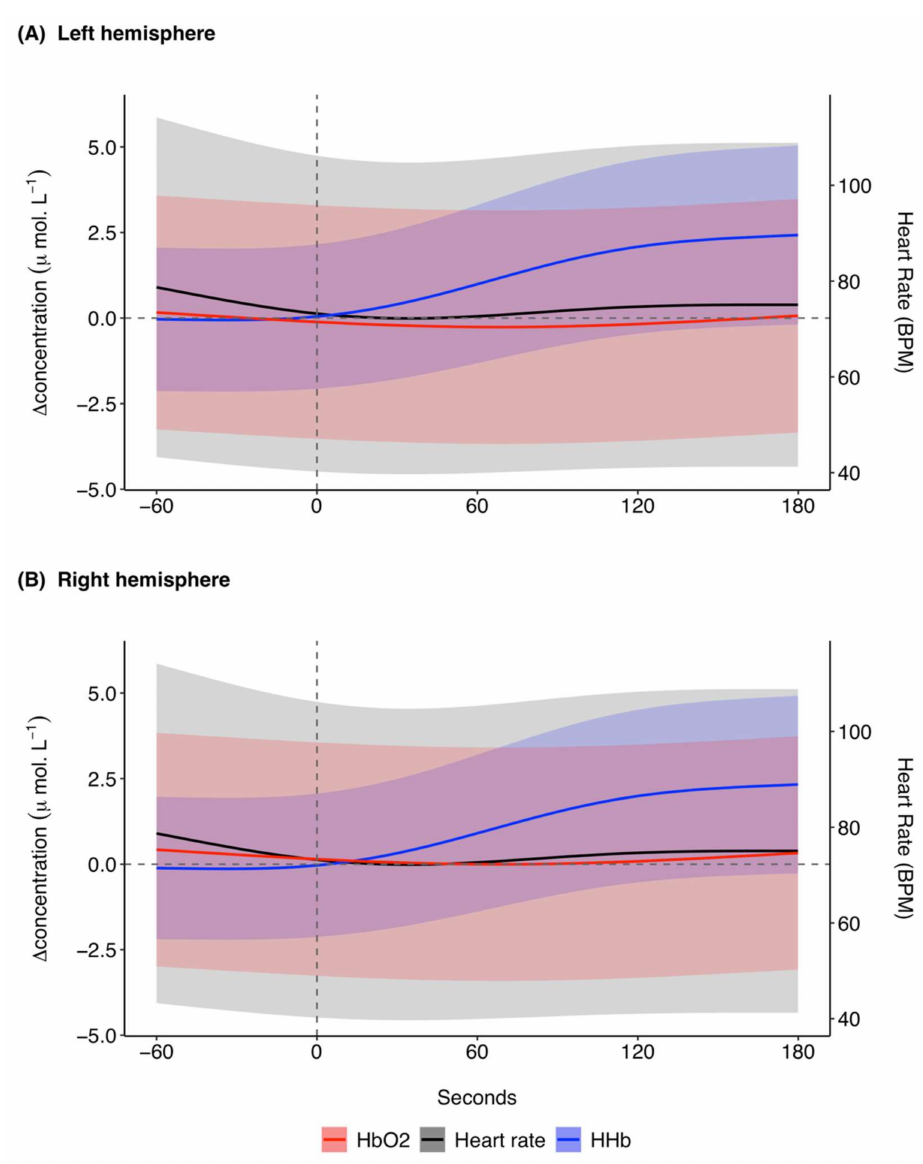
Figure 6. GAMM model prediction outcomes for [ ∆ HHb] ( µ mol L − 1 ), [ ∆ O 2 Hb] ( µ mol L − 1 ), and heart rate (BPM) in the ( A ) left hemisphere and ( B ) right hemisphere for 60 s before and 180 s after midazolam administration at time 0 s for 11 trials across four grey seals. For illustrative purposes a baseline shift was completed so that all concentrations are expressed as relative changes from a baseline (0 µ mol L − 1 ) between the left and right hemispheres at time of drug administration. Changes in heart rate are systemic, meaning the presented model prediction outcomes for heart rate are the same for the left and right hemispheres. The shaded regions represent the 95% confidence intervals. GAMM, generalised additive mixed model; [ ∆ HHb], change in concentration of deoxygenated haemoglobin; [ ∆ O 2 Hb], change in concentration of oxygenated